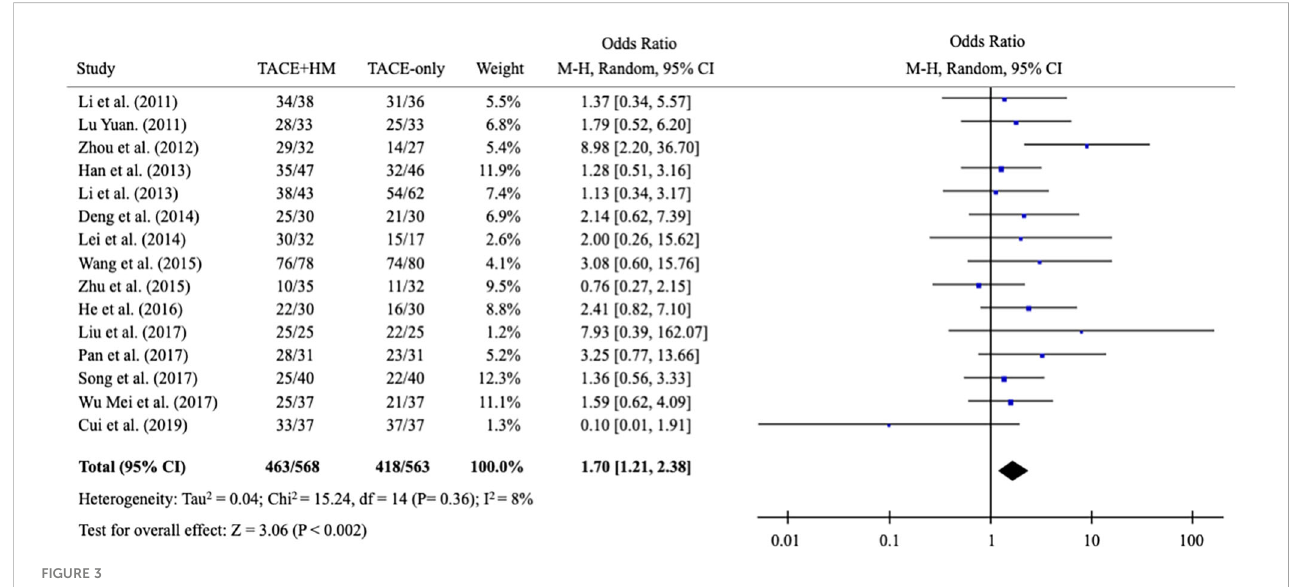
FIGURE 3 Meta-analysis of overall survival at 6-month.